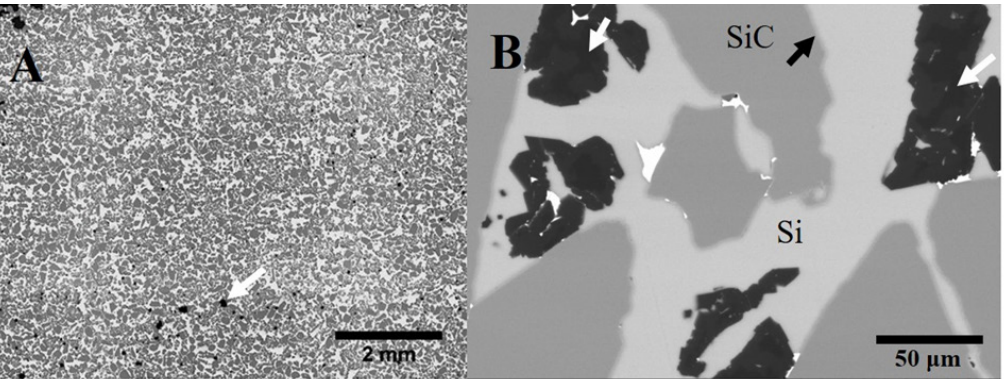
Figure 4. Cross-sections of the SiC-B 4 C-Si composite showing ( A ) an optical view and ( B ) and backscatter SEM mode view. In ( A ), the black regions are pores in the samples (arrow); the lighter shades of grey are the solid phases.